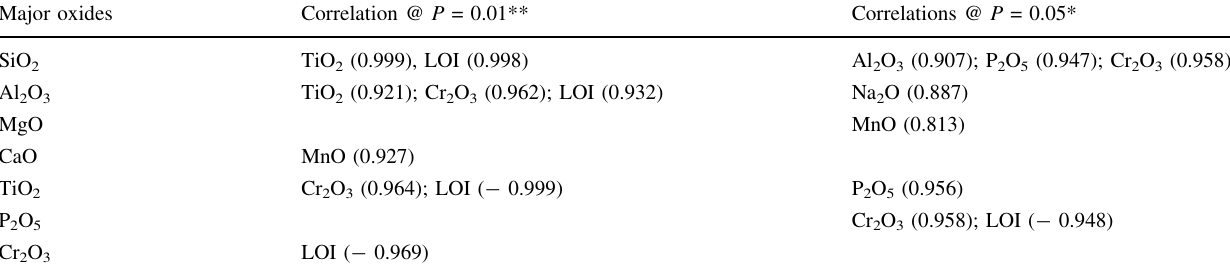
Table 2 Correlation matrix of major oxides in coal Major